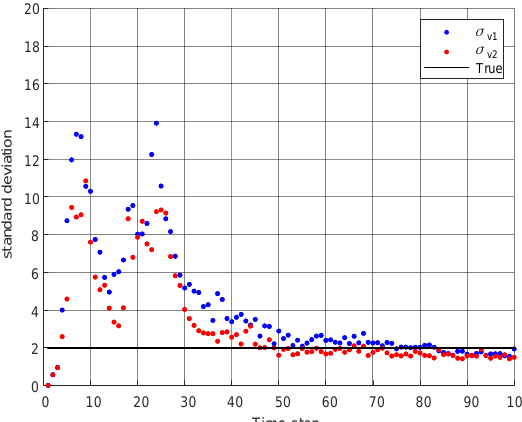
Figure 2. The average standard deviation of estimated measurement noise of AGM-VB-TPHD. The effective number of tracking targets at each time can be seen from the cardinality distribution. The closer the cardinality to the true value is, the lower the target losing